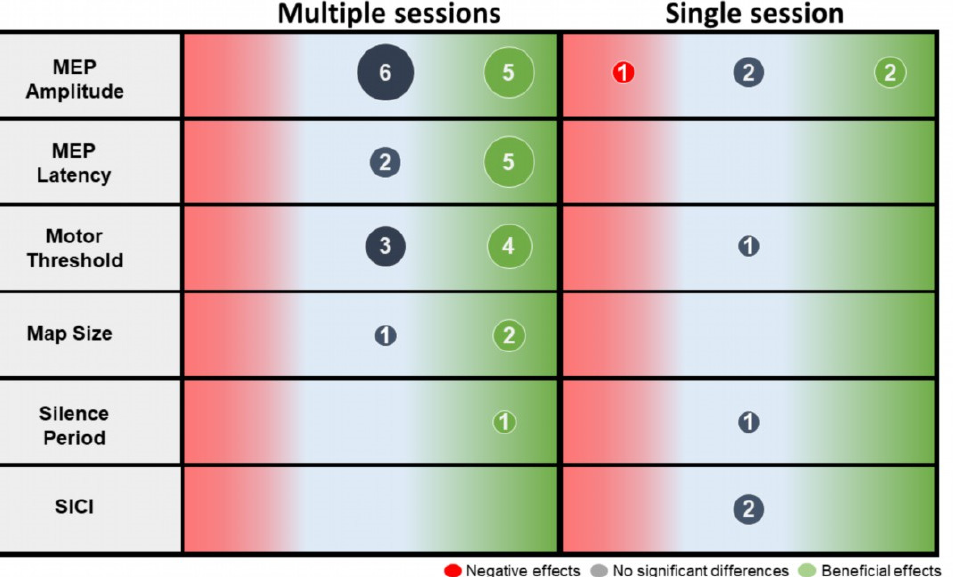
Figure 2. Synthesis of the pre-post effect of single and multiple gait training sessions on corticospinal excitability by reporting the number of articles showing a positive effect (green), no effect (grey) or a negative effect (red). Numbers represent the number of articles. Abbreviations: MEP: motor evoked response, SICI: Short interval intracortical inhibition.